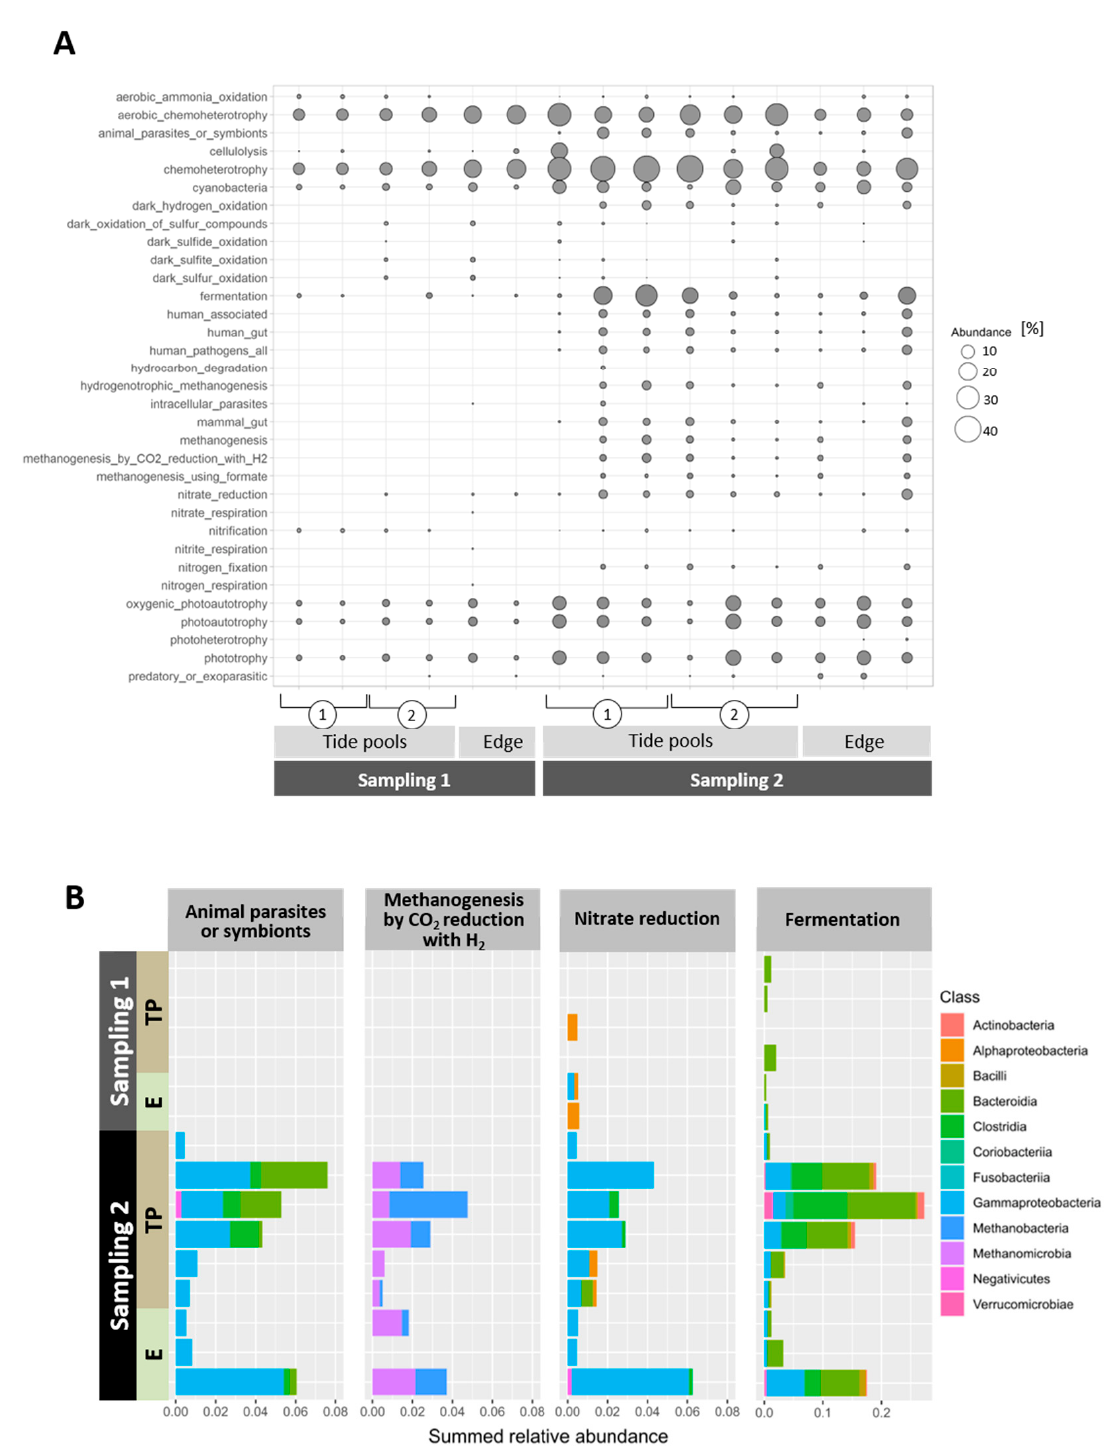
Figure 5. ( A ) Relative functional group abundance of ASVs associated with Neogoniolithon sp. surfaces from platform edge, tidal pool, and aquaria samples and their surrounding waters. ASVs were assigned to functional groups as described in Section 2. Abundance levels represent the sum of all ASVs assigned to a specific function. ( B ) Class level abundance of the main functional categories per study region and timing. TP = tidal pools; E = edge. Values represent the fraction from total ASVs identified per sample.